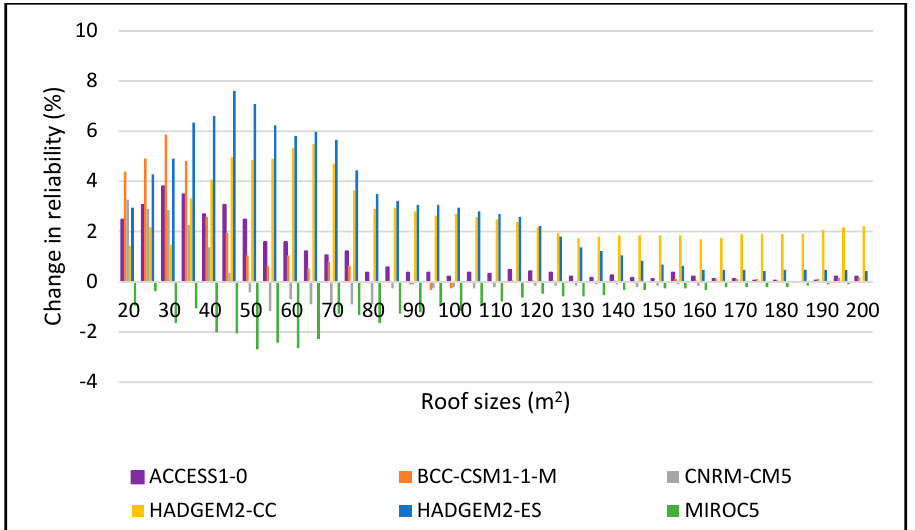
Figure 14. Change in reliability for DJF 2060–2090 period for 2 m 3 .